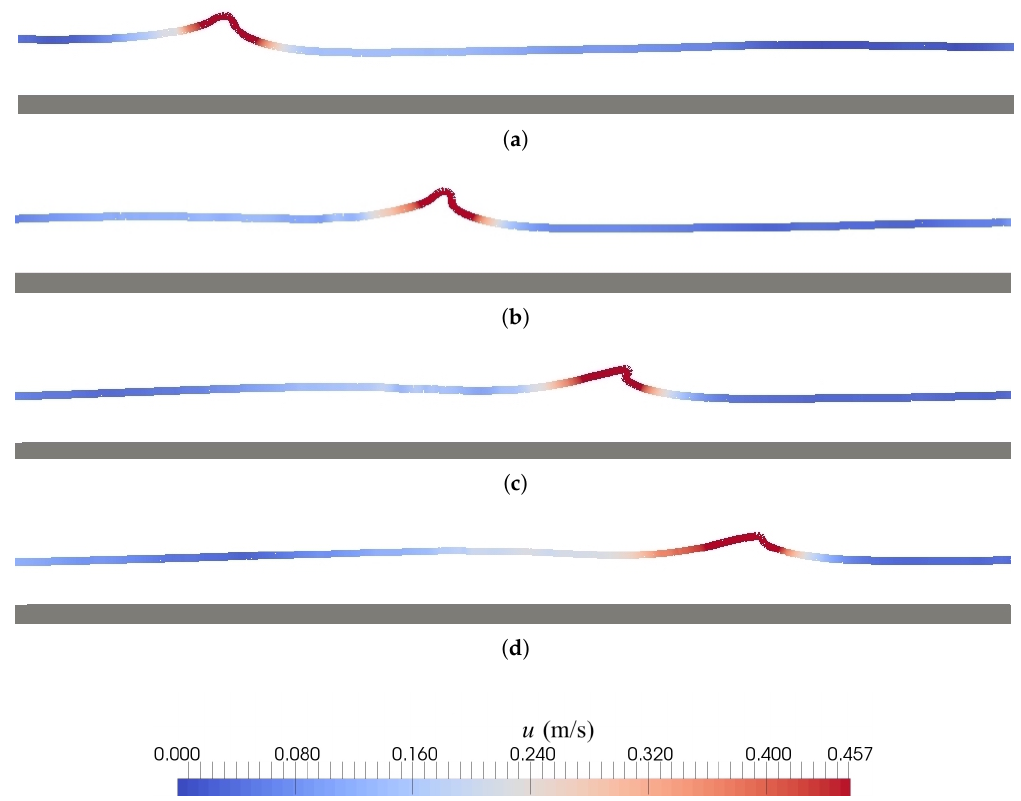
Figure 7. Numerically reconstructed irregular wave free surface over a submerged bar (zoomed around the free surface) at t / T p = ( a ) 19.14 s; ( b ) 19.32; ( c ) 19.58; ( d ) 19.85.